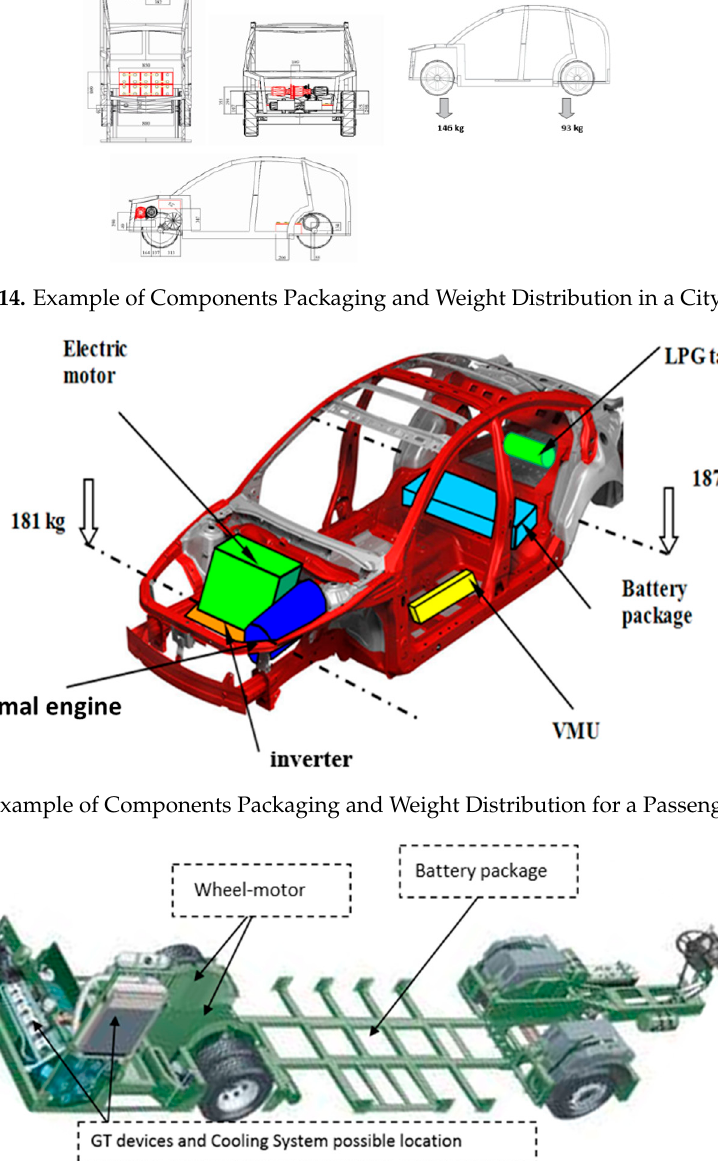
Figure 16. Example of Components Packaging and Weight Distribution for an Extra-urban Bus.